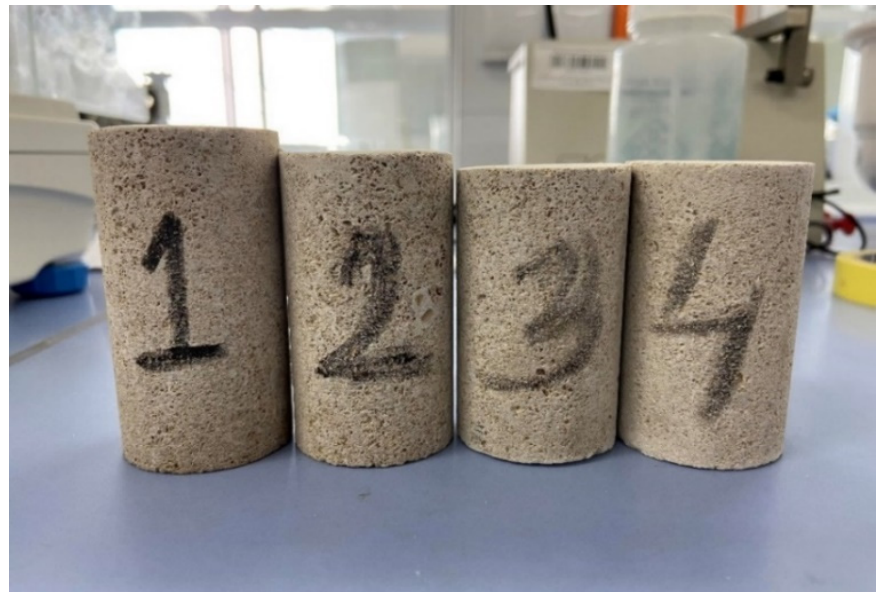
Figure 1. Indiana limestone core samples used in coreflood-1 through 4. Table 1. Dimensions of the core samples.